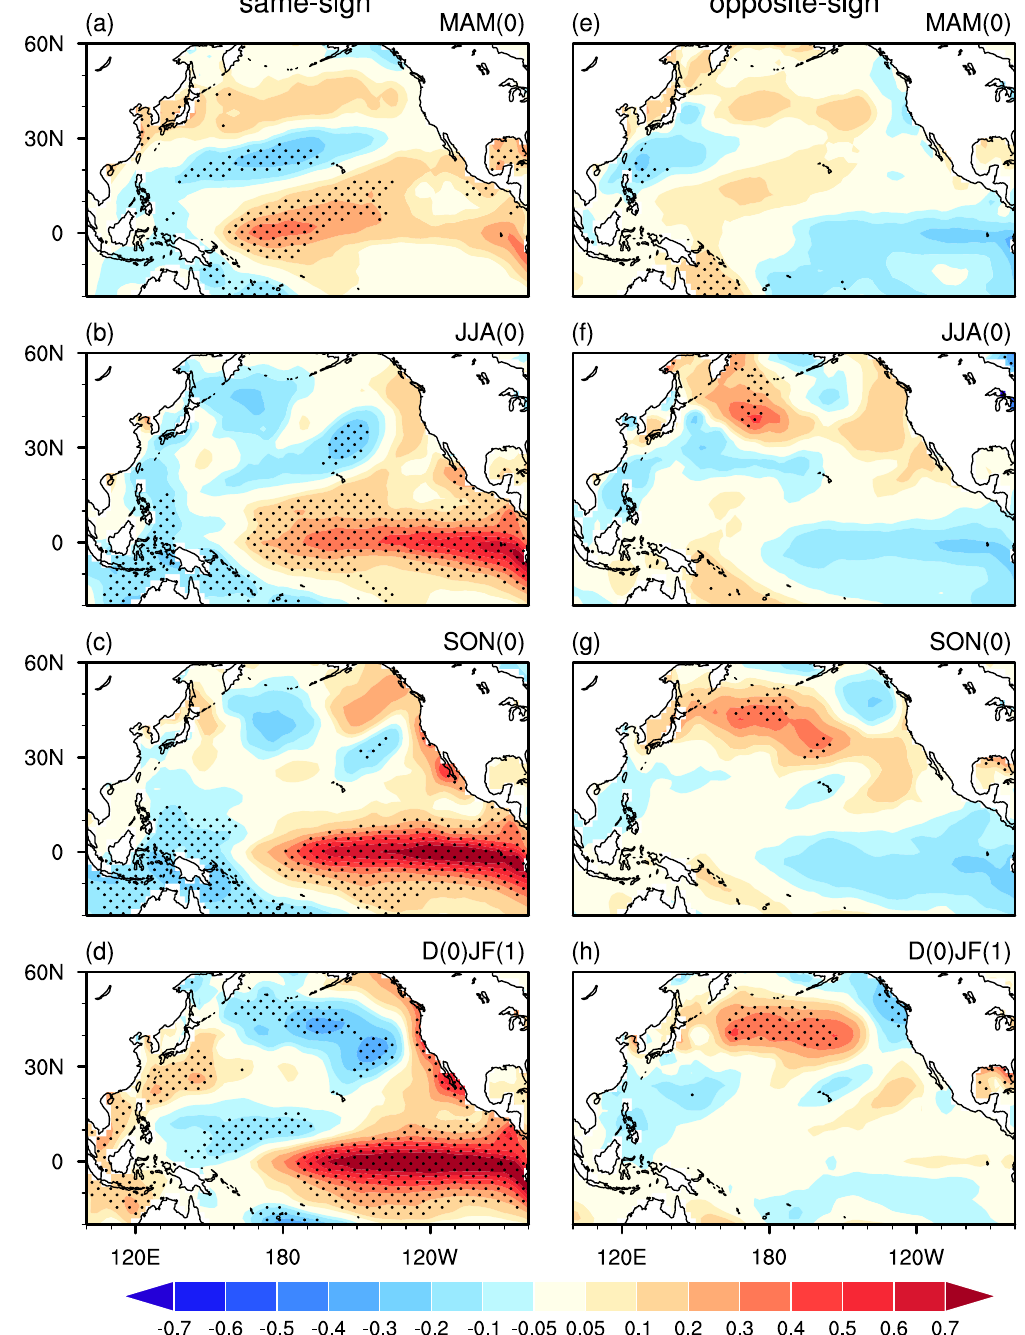
Figure 2. Anomalies of SST (°C) at ( a , e ) MAM(0), ( b , f ) JJA(0), ( c , g ) SON(0), and ( d , f ) D(0)JF(1) regressed upon the spring AO index, constructed respectively, for the years when the spring AO index and the preceding November AO index have the (left) same and (right) opposite signs. Stippling regions indicate SST anomalies that significantly difference from zero at the 95% confidence